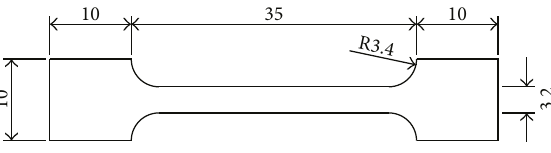
Figure 5: Test sample size (in